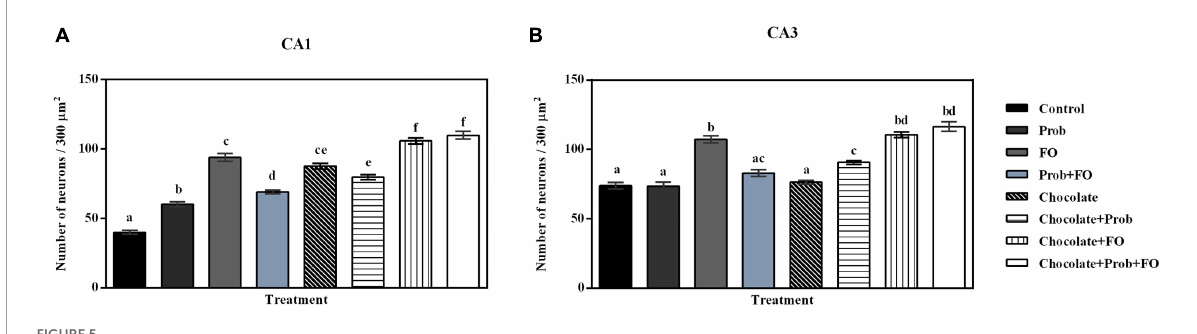
FIGURE5 Nuclei count in the hippocampus of the different treatment brain samples. Prob, probiotics; FO, fish oil. (A) Hippocampal CA1 region, (B) Hippocampal CA3 region. Different letters among bars indicate statistically significant differences between treatments by the LSD test ( p <